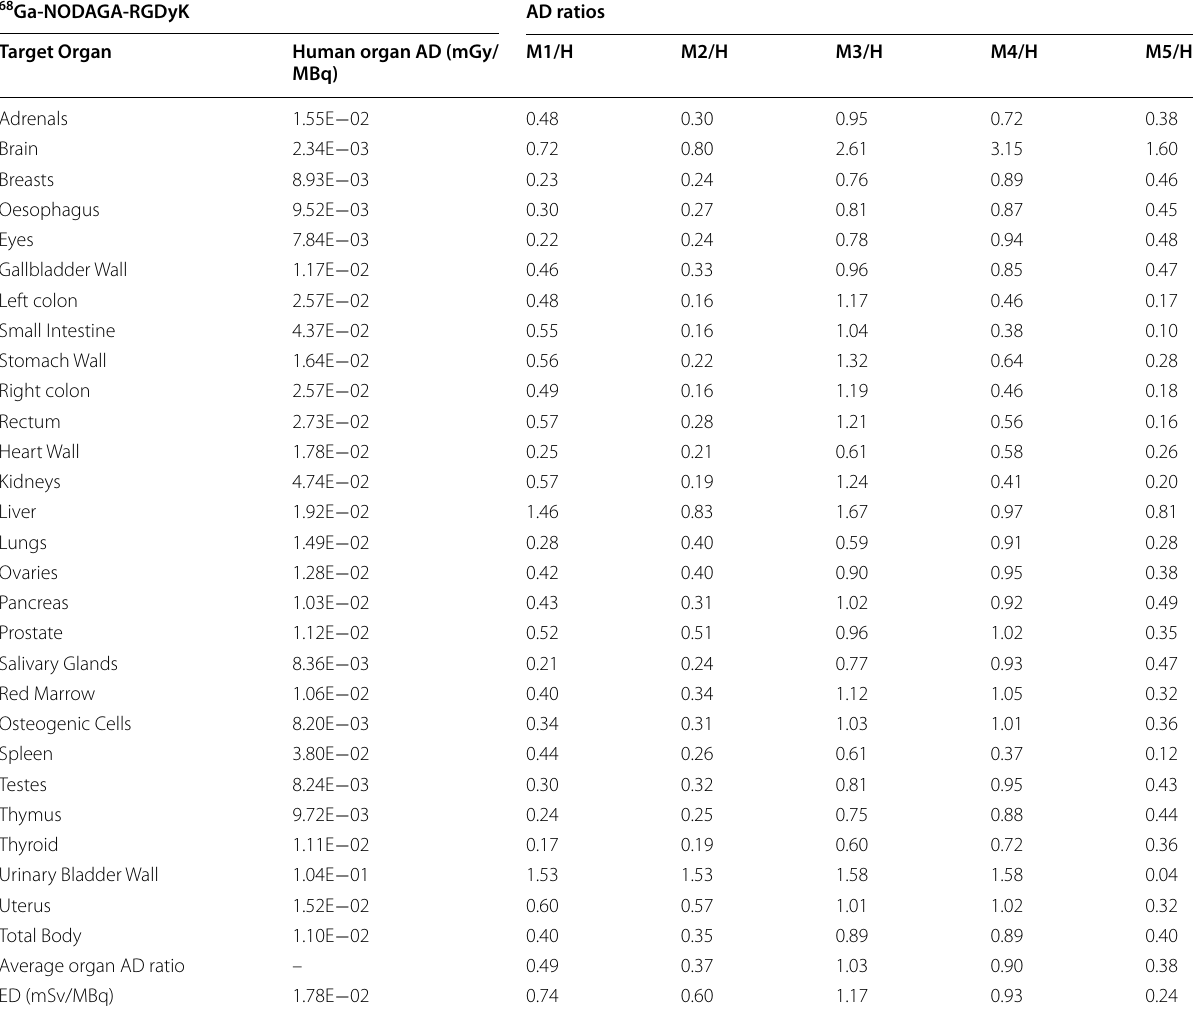
Table 3 Comparison between mice-to-human dose extrapolations and dosimetry directly calculated on human subjects for [ 68 Ga]